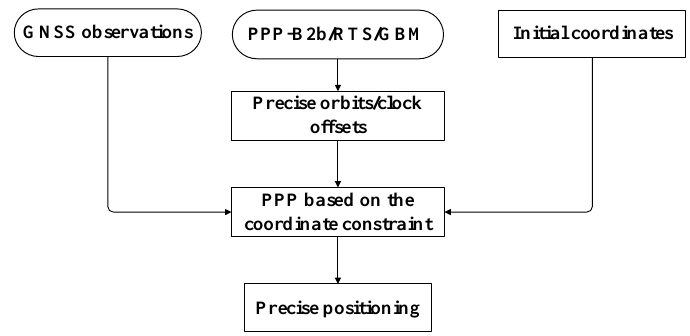
Figure 1. Flowchart of processing.